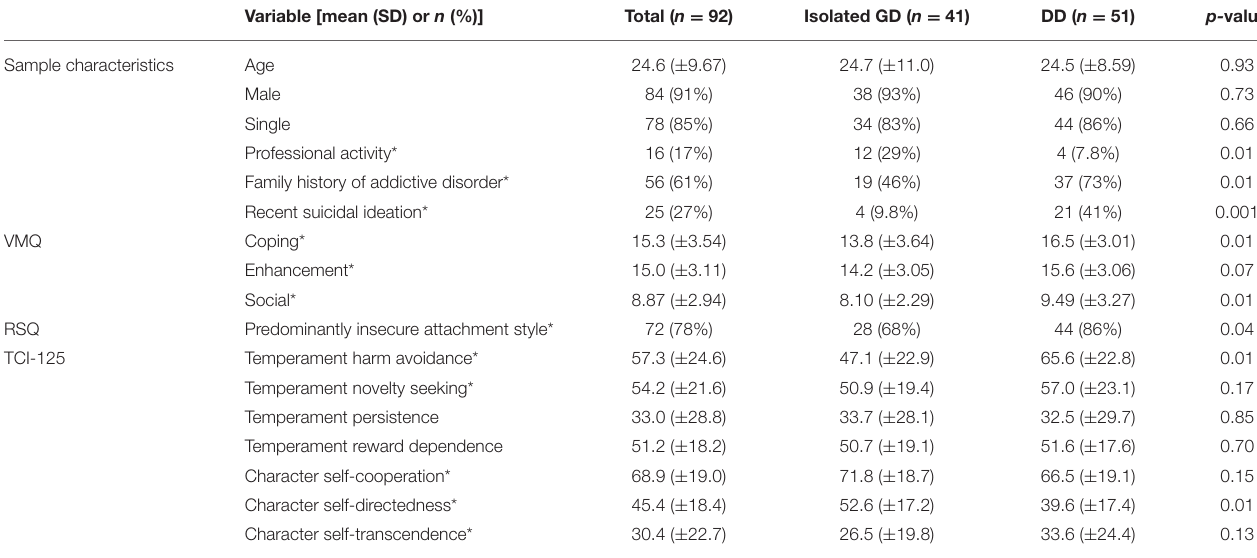
TABLE 1 | Sample description and univariate analyses by the presence or absence of dual diagnosis among gaming disorder patients ( N = 92). Variable [mean (SD) or n